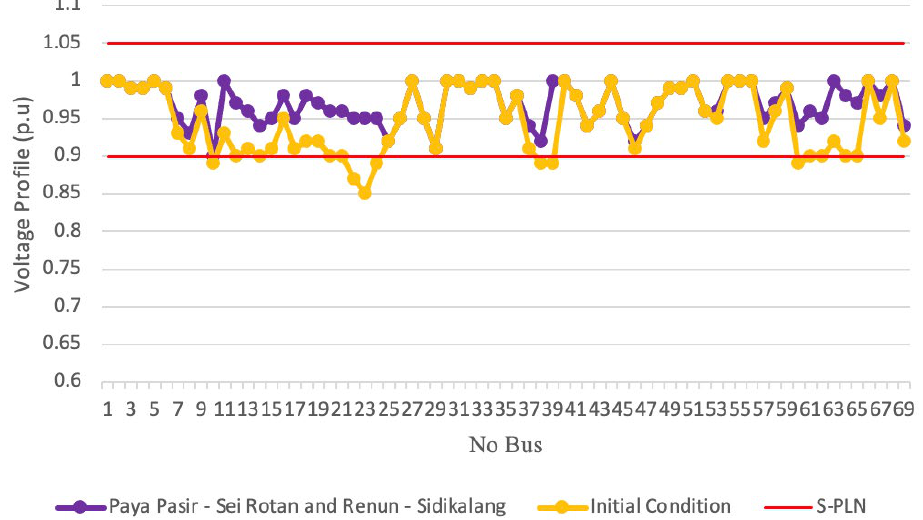
Figure 12. Voltage profile of the SUMBAGUT 150 kV transmission system after changing the Paya Pasir (Bus 5)–Sei Rotan (Bus 11) and Renun (Bus 66)–Sidikalang (Bus 63) lines to the HVDC transmis- sion